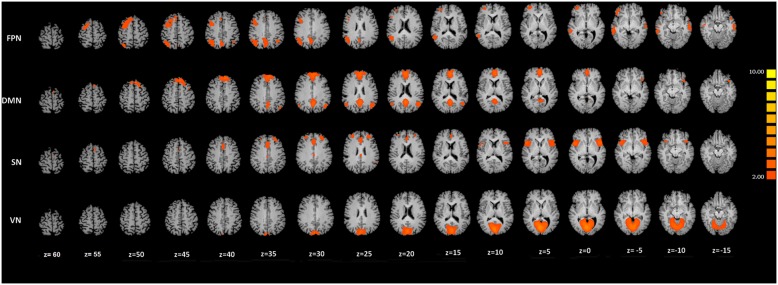
ICNs observed pooling both groups.Spatial patterns observed during erotic video clip presentation. Fronto-Parietal Network (FPN), Default-Mode Network (DMN), Salience Network (SN) and Visual Network (VN). Maps are overimposed on a Talairach atlas and are in radiological convention with a threshold of Z = 2.